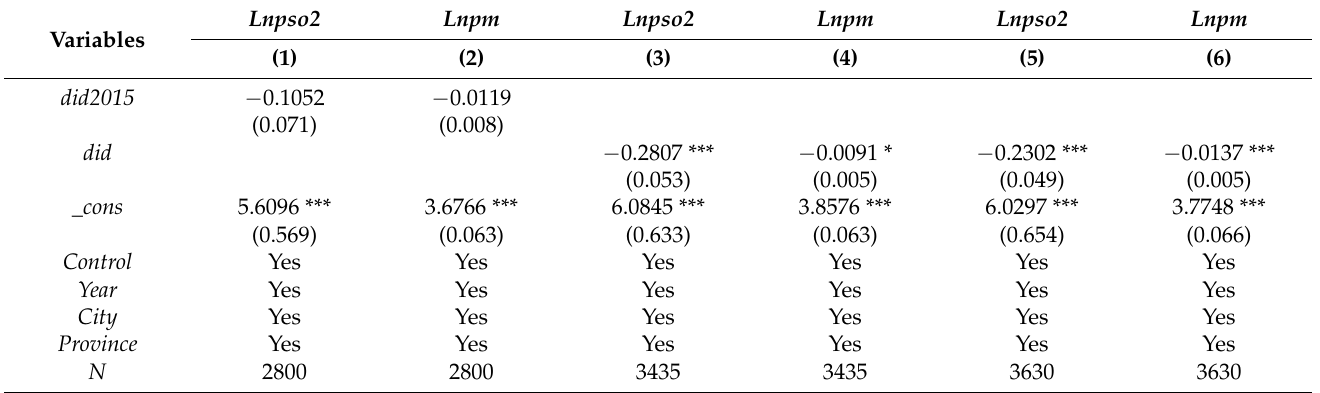
Table 4. Regression results after excluding other policy